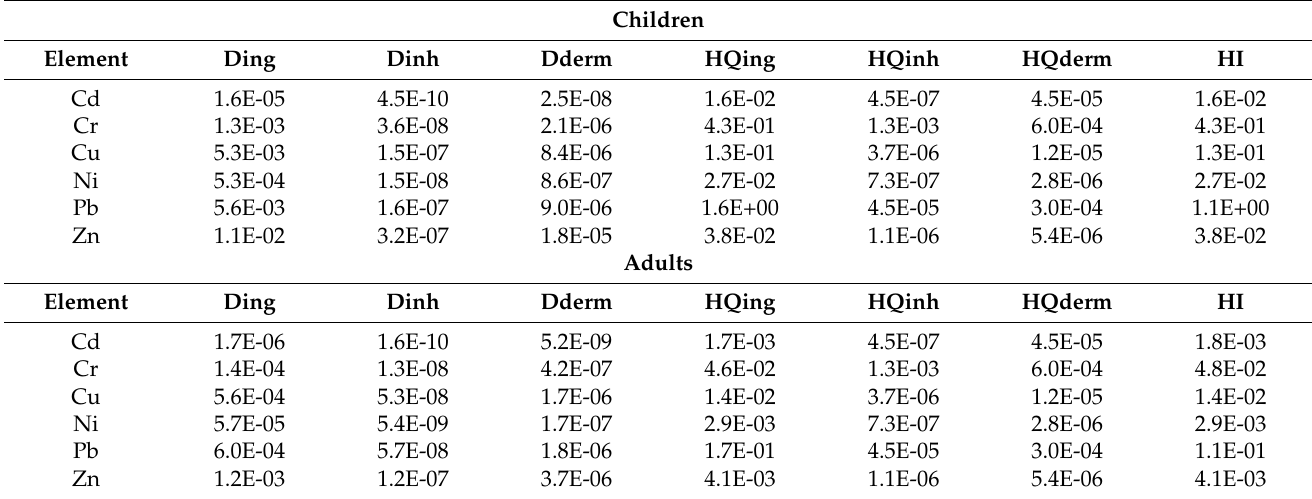
Table 4. Mean non-cancer index values for children and adults: Ding, Dinh, and Dderm (mg kg − 1 day − 1 ) and Hazard Quotient for each element and exposure route.